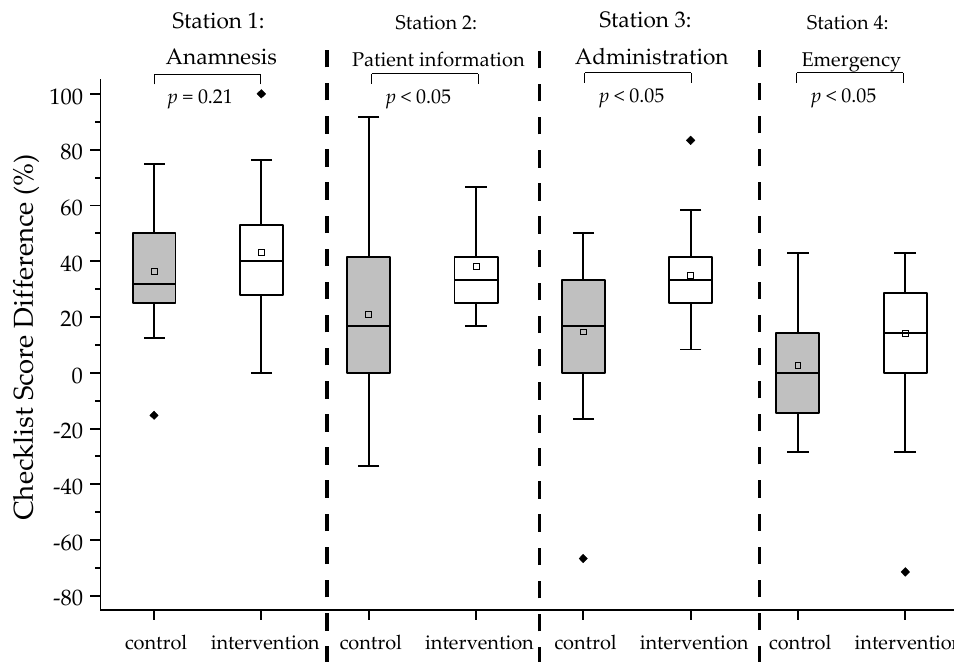
Figure 5. Box plots of analytical checklist score difference between pre- and post-Training OSCE. A one-sided Mann–Whitney test with a significance level of alpha = 0.05 was used to compare OSCE scores between groups.